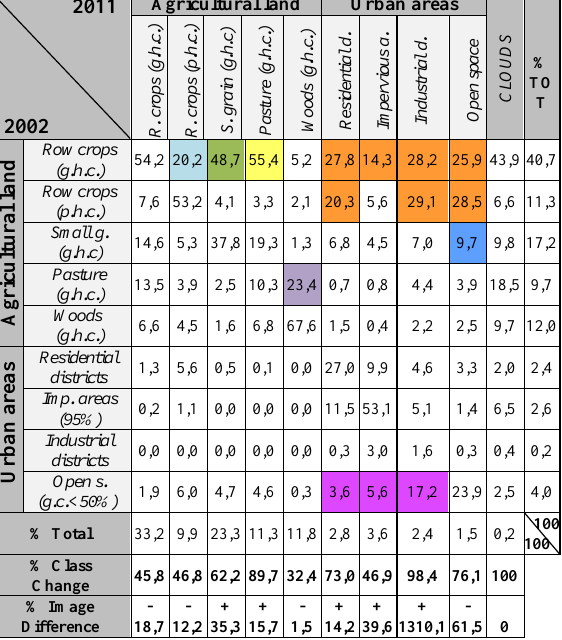
Table 4. Matrices of land cover (LC) and changes